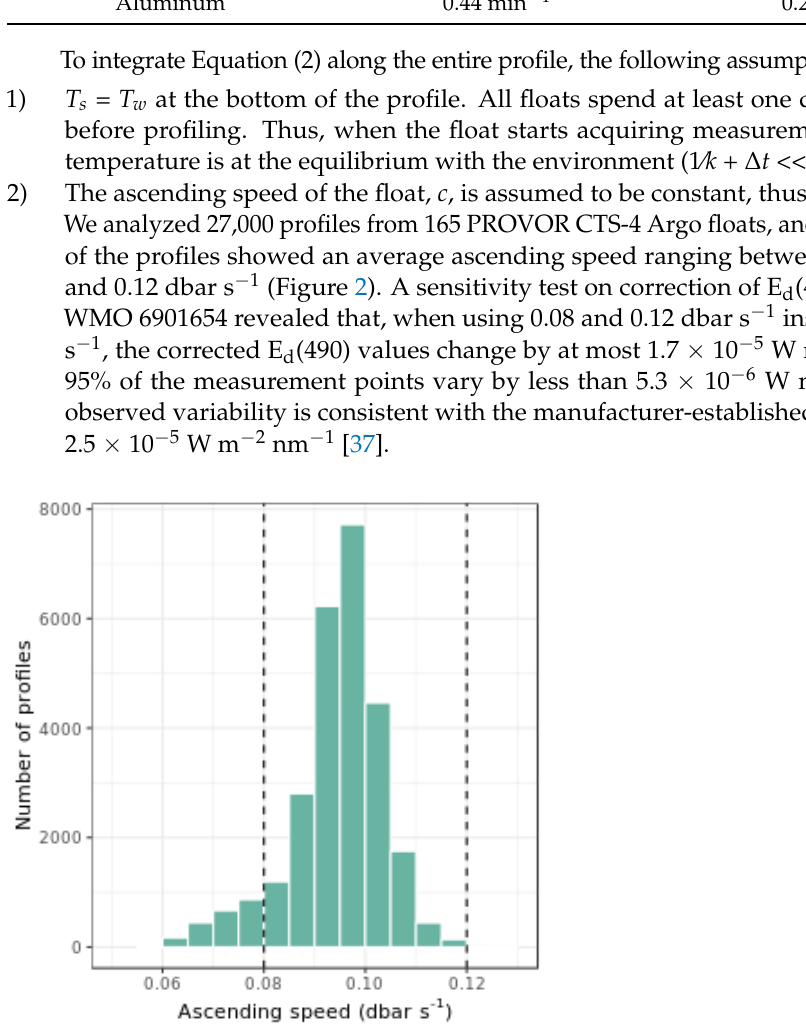
Figure 2. Histogram of the average float ascent speed for 27000 BGC-Argo radiometry profiles, reconstructed from the available time stamps in the trajectory profile. Vertical dashed lines indicate the two values used for the sensitivity test which interval includes 91% of tested profiles.